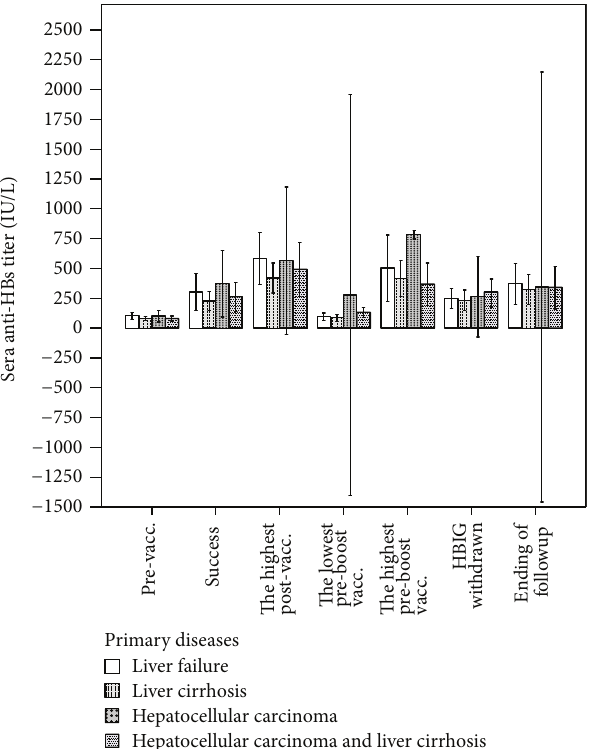
Figure 3: There were no significant differences among patients with LF,HCC,LC,andHCCcombinedwithLCinbaselineanti-HBstiter, titer at successful establishment of immunity, the highest titer after vaccination, the highest titer after booster vaccination, titer when HBIG was withdrawn, and titer at the ending of followup. The lowest titer of the HCC group before booster vaccination was higher than that of the other groups (94.81 ± 3.84 IU/L versus 87.40 ± 57.29 IU/L, 277.90 ± 187.38 IU/L, 131.74 ± 59.90 IU/L, 𝐹 = 6.110 , and 𝑃 = 0.002 , vacc.: vaccination).